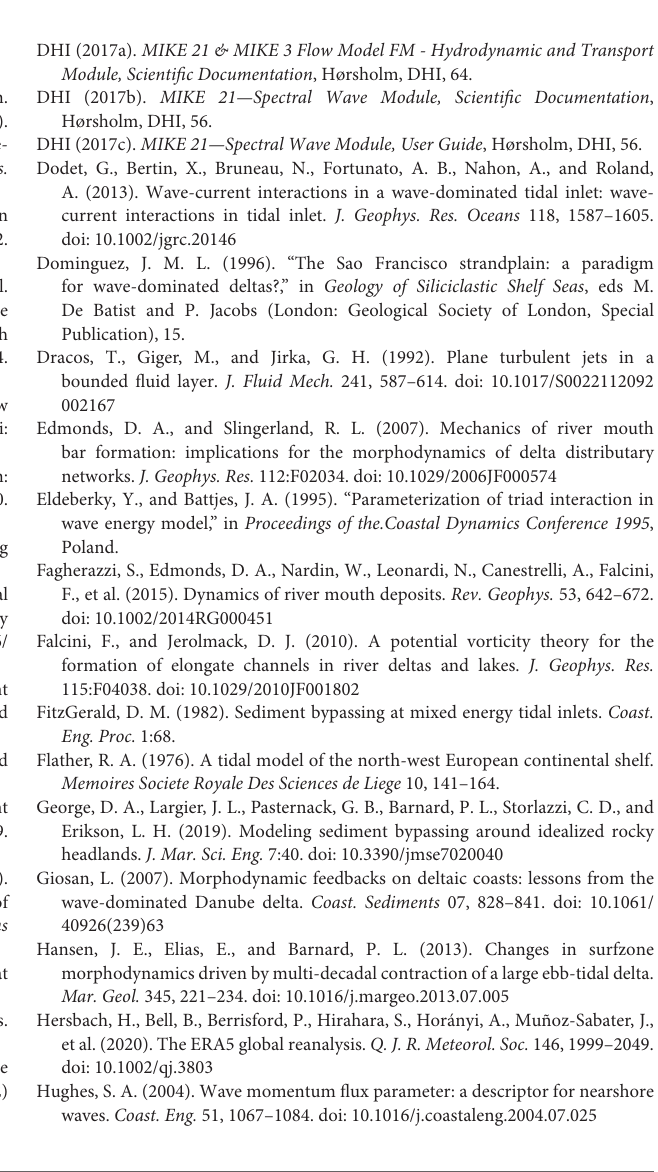
Supplementary Figure 1 | Model mesh at three levels showing the decreasing size of triangular grids (left); zoom on the river mouth (right). The elevation scatter on the basis of which the bathymetries have been interpolated is also shown. Supplementary Figure 2 | The “plateau effect”: Upper plots show increasing Hs with Q8000 resulting in a progressive increase in DyD . Bottom plots show increasing Hs with Q2000 with a limited increase in DyD due to the higher diversion of the jet in front of the RMB before maximum Hs thresholds. Supplementary Figure 3 | Storm and flood simultaneous occurrences in front of the Sfântu Gheorghe (A) and Grand Rhône river mouths (B) . (A1,B1) wave roses based on ERA5 data; (A2,B2) daily discharge data; (A3,B3) hourly Hs based on ERA5; (A4,B4) heat plot showing the number of simultaneous occurrences of Hs and Q conditions; (A5,B5) histogram of Q ; (A6,B6) histogram of Hs .